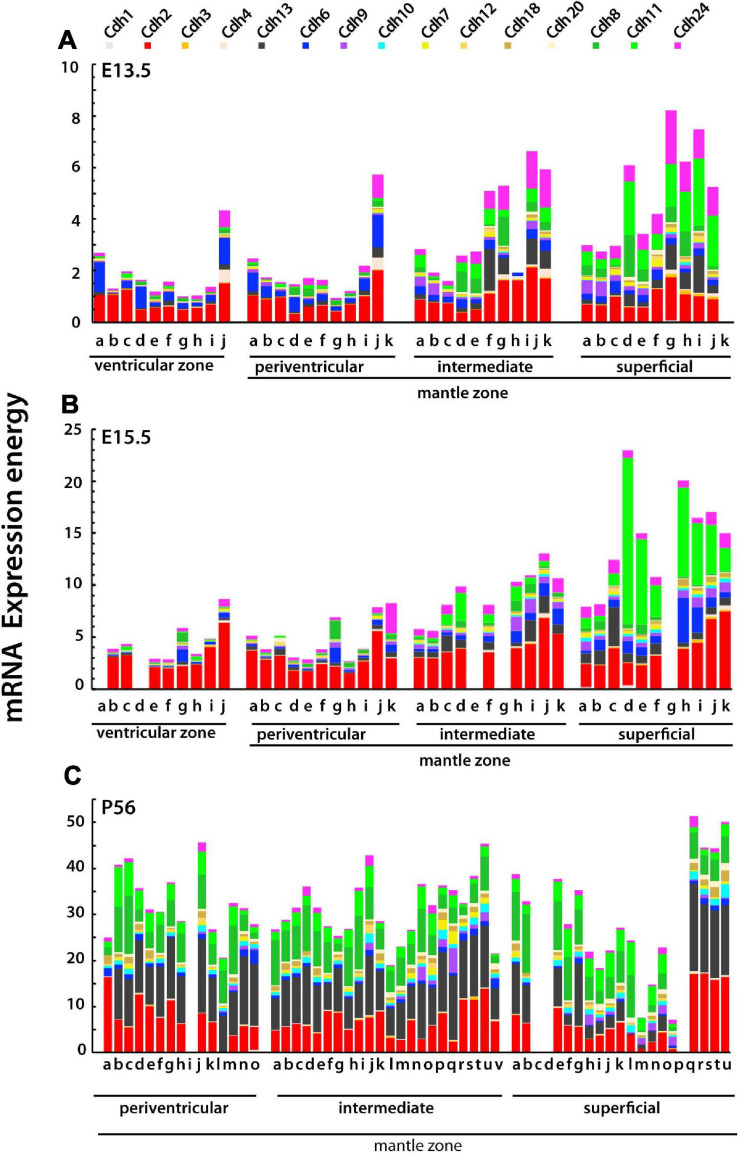
Type I and type II cadherins mRNA expression energy values in each neuroanatomical structure of the subpallium grouped by stratum at E13.5, E15.5, and P56. Each color-coded portion of the stacked bars displays the mRNA expression energy of a cadherin in each neuroanatomical structure from by ISH experiments. (A) E13.5 (ontological levels 9 and 10); (B) E15.5 (ontological levels 9 and 10); and (C) P56 (ontological levels 11 and 12). (A,B) Ventricular zone: a, DgSev; b, PalSev; c, StrSev; d, SeDgv; e, SePalv; f, SeStrv; g, Dgv; h, Palv; i, Strv; j, AStrv. Periventricular stratum: a, DgSep; b, PalSep; c, StrSep; d, SeDgp; e, SePalp; f, SeStrp; g, Dgp; h, Palp; i, Strp; j, AStrp; k, APalp. Intermediate stratum: a, DgSei; b, PalSei; c, StrSei; d, SeDgi; e, SePali; f, SeStri; g, Dgi; h, Pali; i, Stri; j, AStri; k, APali. Superficial stratum: a, DgSes; b, PalSes; c, StrSes; d, SeDgs; e, SePals; f, SeStrs; g, Dgs; h, Pals; i, Strs; j, AStrs; k, APals. (C) Periventricular stratum: a, MnSC; b, LSIp; c, LSD; d, TS; e, SFi; f, BSTMS; g, BSTMv; h, BSTMa; i, SePalp; j, AcbCo; k, BSTMC; l, BSTLC; m, Cau; n, ASt; o, BSTLA. Intermediate stratum: a, LSIV; b, SHy; c, LSII; d, Ld; e, LSID; f, SIBT; g, BAC; h, SePalCo; i, SePalSh; j, AcbSh; k, SIB; l, IPal; m, EPal; n, VPal; o, Put; p, VStr; q, IPAC; r, LSS; s, CeL; t, CeC; u, IA; v, CeM. Superficial stratum: a, VDB; b, MS; c, PalSes; d, StrSes; e, HDBT; f, TuSePal; g, ICjM; h, TuSeStr; i, TuPal1; j, TuPal2; k, TuPal3; l, ICjPal; m, TuStr1; n, TuStr2; o, TuStr3; p, ICjStr; q, AStrs; r, MePD; s, MePV; t, MeAD; u, MeAV. The complete names of neuroanatomical structures are listed in Supplementary Table 1.